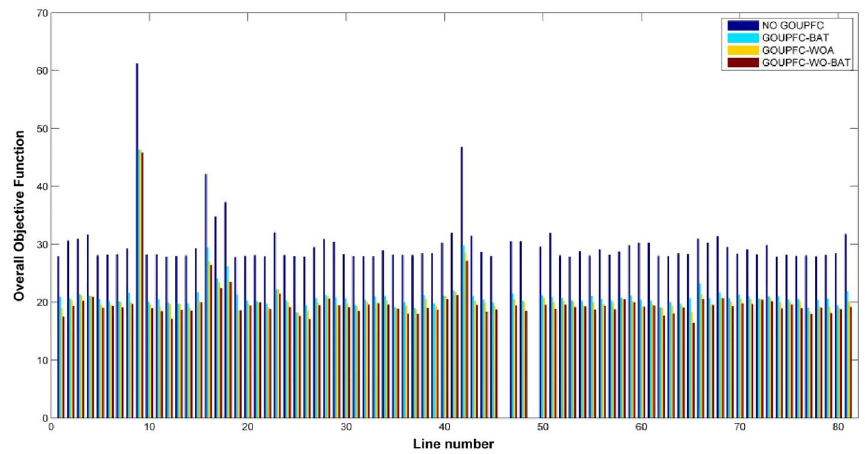
Fig. 8 GOUPFC performance under single line contingency and 30%